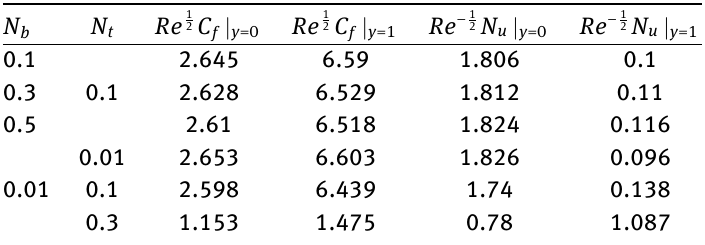
Table 2: Local skin friction coefficient C f and the local Nusselt number N u for physical parameters N b , N t in region-I keeping h = 1, λ 1 =